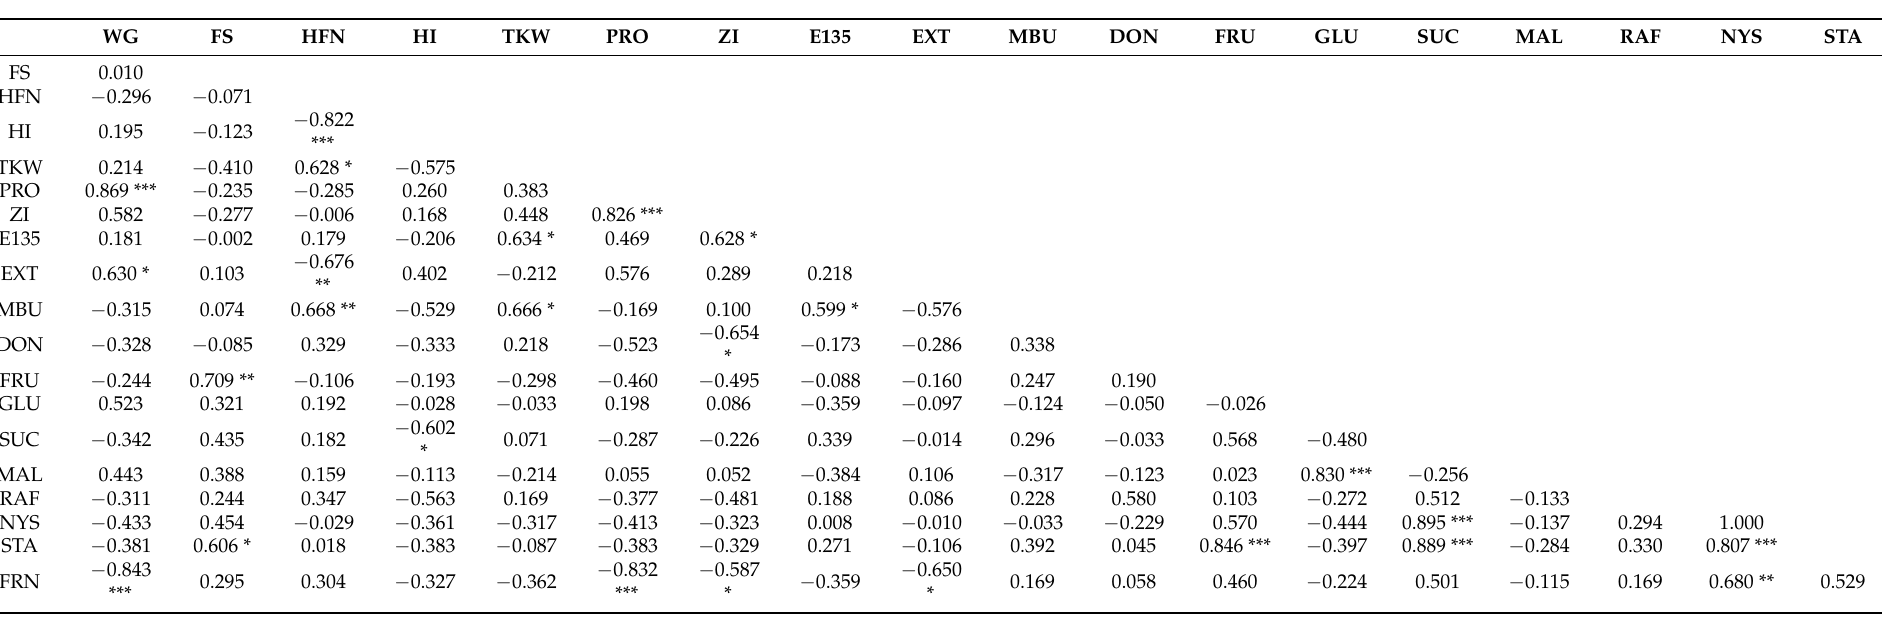
Table A1. Pearson’s correlations between simple carbohydrate content, wheat quality parameters and DON toxin after responses of fungicide treatments,